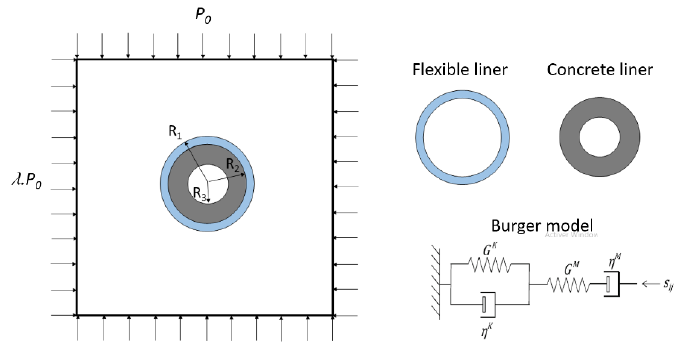
Figure 1. Deep tunnel with double liners in a viscoelastic Burger rock under anisotropic initial stresses.